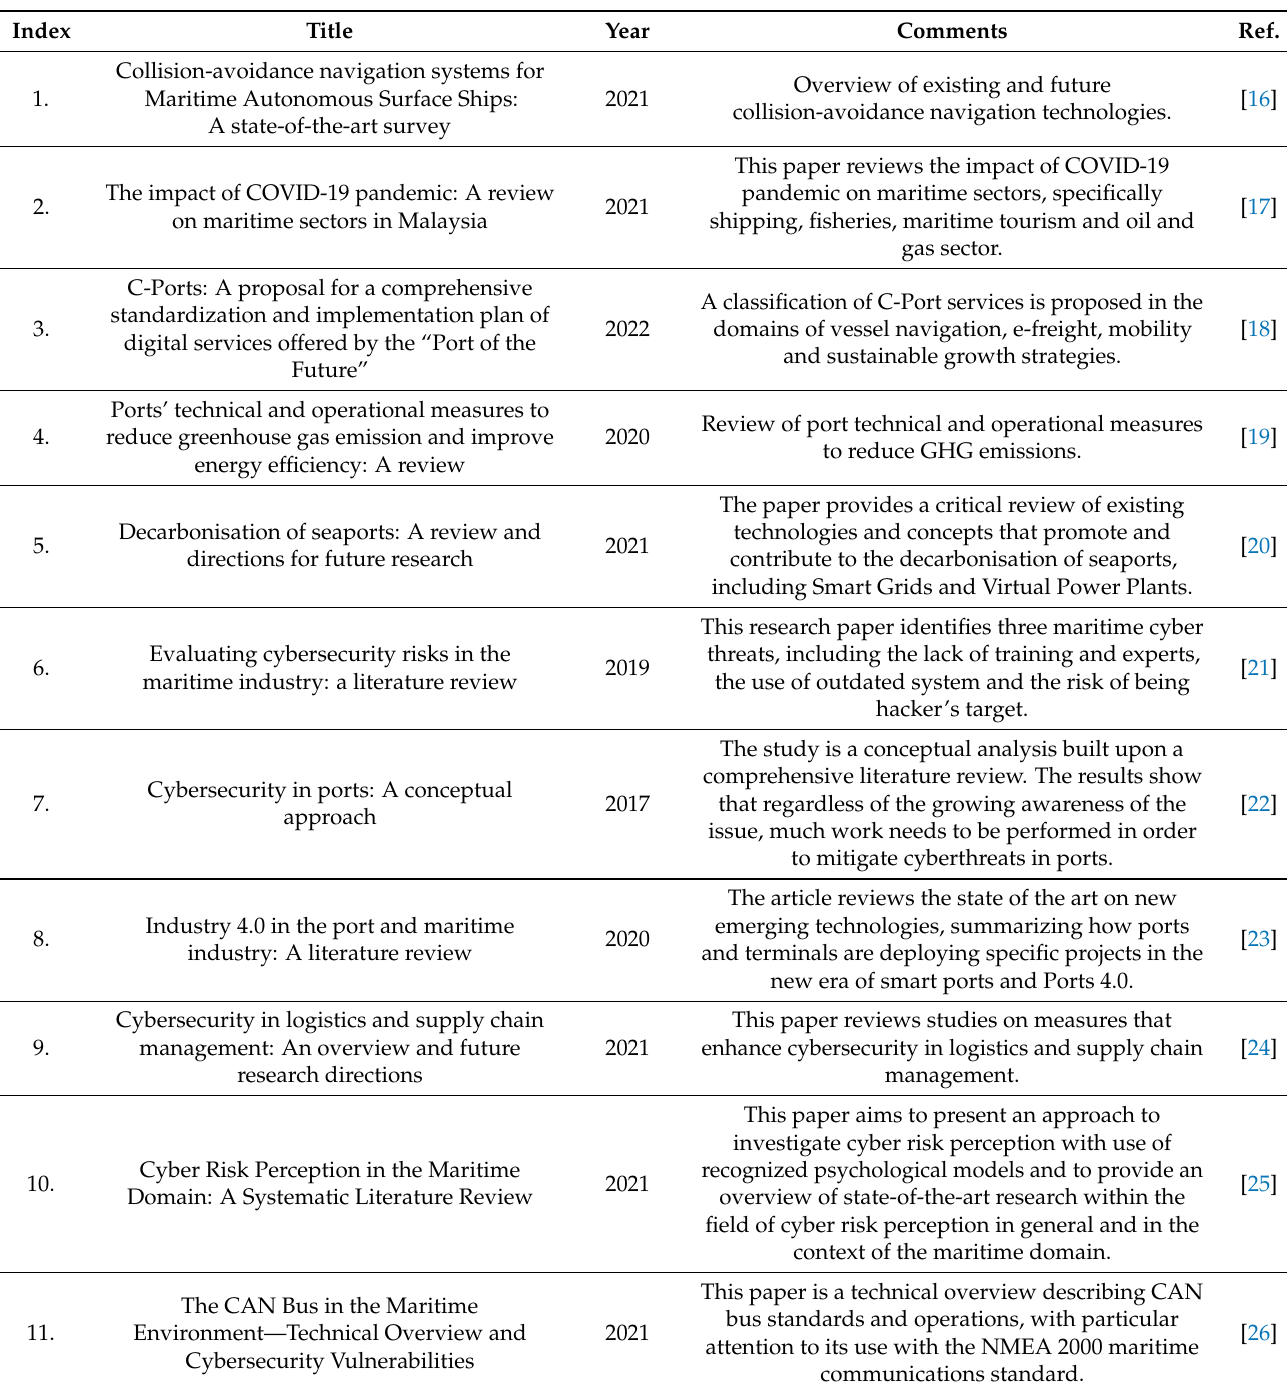
Table 1. Summary of significant recent survey papers on vessels/maritime